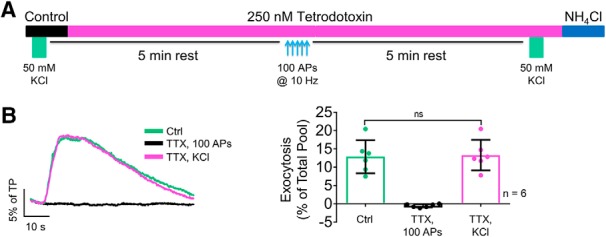
Elevated KCl depolarization-evoked SV exocytosis is NaV independent. A, Schematic of the protocol used to determine the effect of TTX on exocytosis evoked by elevated KCl or electrical stimulation. B, Representative traces of vMAT2-pHluorin response to elevated KCl depolarization or electrical stimulation in the absence or presence of 250 nM TTX (left). Mean values of vMAT2-pHluorin response amplitudes (right). ns, not significant by paired one-way ANOVA with Tukey’s post hoc test.